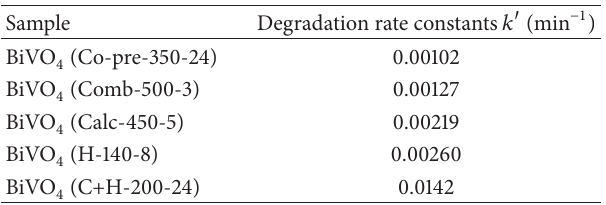
Table 3: Pseudo-first-order rate constants 𝑘 󸀠 using Langmuir- Hinshelwood kinetics for various BiVO 4